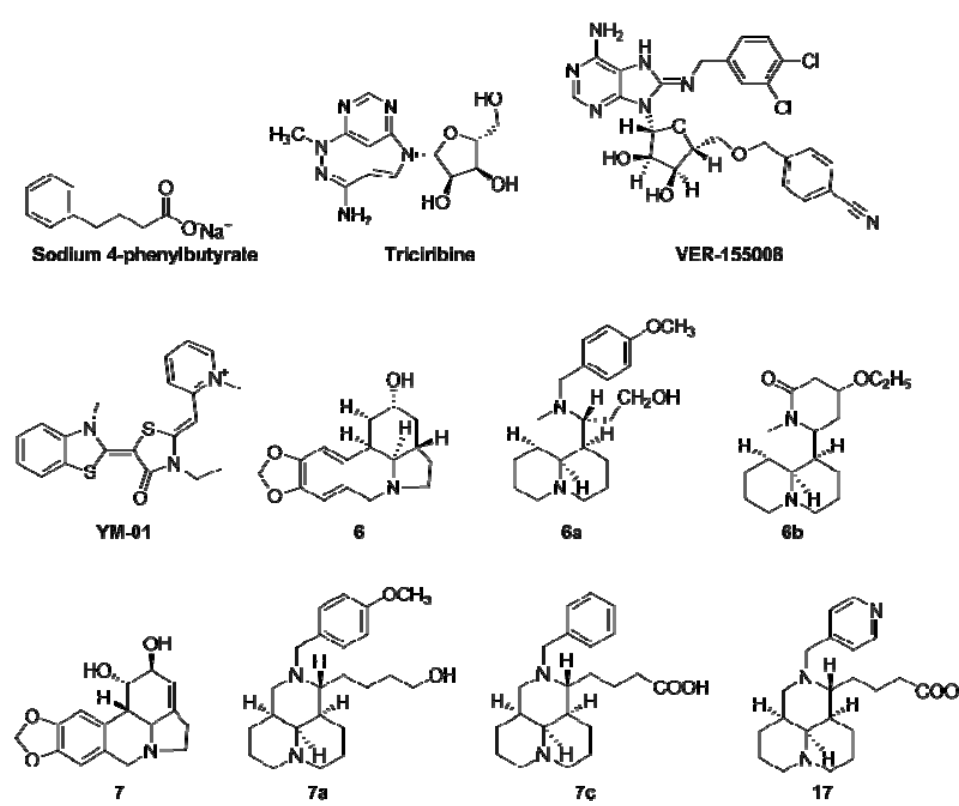
Figure 4. Structures of HSPA8 inhibitors. Compounds: 6a , 12 N -(4-Methoxybenzyl)matrinic ethanol dihydrochloride; 7a , 12 N -(4-Methoxybenzyl)matrinol dihydrochloride; 6 , Dehydro-1-deoxylycorine; 7 , Lycorine; 17 , 12-(4-Pyridylmethyl)matrinic acid dihydrochloride.